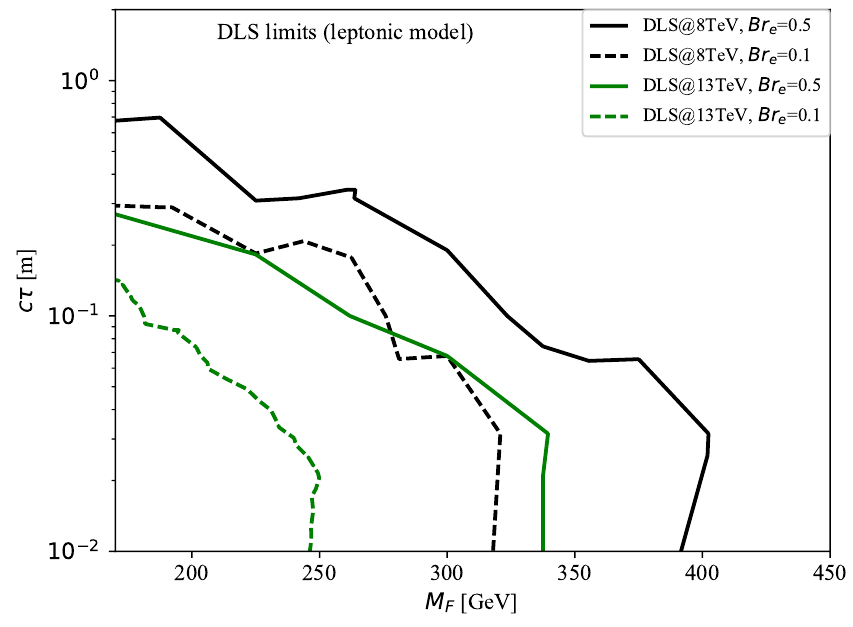
Figure 5 . 95 % C.L exclusions in the c(cid:28) vs m F plane due to the 8 TeV (19.7 fb (cid:0) 1 , black) and 13 TeV (2.6 fb (cid:0) 1 , green) CMS Displaced Lepton searches. The solid curve indicates the case where Br ( F ! es ) (cid:17) Br e = 0 : 5 and Br ( F ! (cid:22)s ) (cid:17) Br (cid:22) = 0 : 5, while the dashed line denotes the case where Br e = 0 : 1 and Br (cid:22) = 0 :